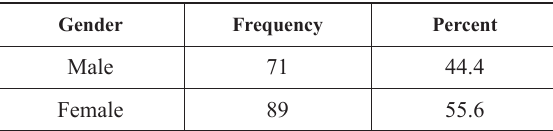
or hugging or elbow greeting or shoulder greeting) when they see someone they know (statement 2). It can be seen that 91.9% of the participants did keep social distancing of at least one meter (statement 3). The majority (83.8%) of the participants did believe that social distancing is an effective measure to prevent Coronavirus (statement 4). It was observed that 89.3% of the participants did wash their hands frequently to avoid the contamination of Coronavirus (statement 5). One person did not respond. Around 87.5% of the participants did carry hand sanitizer when they go out (statement 6). More than three quarters (78.6%) of the participants did use hand sanitizer immediately after touching an external surface (statement 7). About 78% of them were not against the rule of staying at